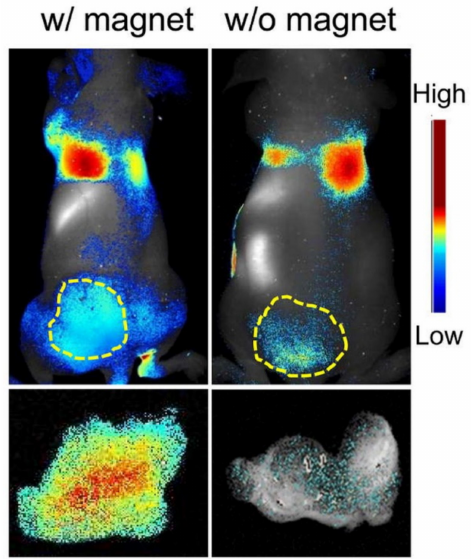
Figure 12. (Upper row) In vivo imaging results. Correlating with the MRI data, significantly more fluorescence signals were observed in tumors that were attached with a magnet. (Bottom row) Ex vivo imaging with dissected tumors. Compared to the controls, the researchers observed a 6.4 times higher accumulation of diatoms in the tumors that had been attached with a magnet during the process. Reproduced from [81], copyright (2014), with permission from The Royal Society of Chemistry.